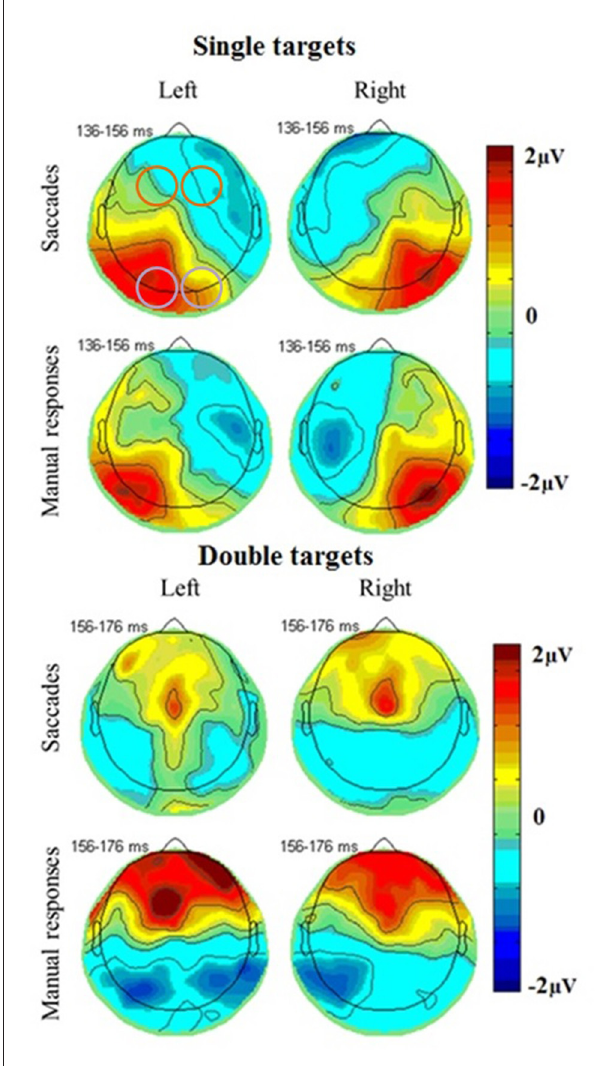
FIGURE 4 | Topographical plots of EEG responses in single (top) and double (bottom) target conditions averaged across all subjects. The electrode clusters extracted for analyses are marked in orange (frontal cluster around FC3 [EGI 12, 13, 19, 24, 20, 28, 29] and FC4 [EGI 4, 5, 111, 112, 117, 118, 124]) and purple (occipital cluster O1 [EGI electrodes 65, 66, 70, 71, 69, 74] and O2 [EGI electrodes 90, 84, 76, 83, 82, 89]) in the first plot. A posterior response to single targets on the left (left plots) and right (right plots) side of the screen is more pronounced in the ipsilateral hemisphere for both saccades (top) and manual responses (bottom) and coincides with a fronto-central negativity. Double target trials in which subjects subsequently responded to the right (right plots) or left (left plots) target show a late frontal positivity coinciding with a posterior negativity for both saccades (top) and manual responses (bottom) that is not lateralized with respect to the selected target but slightly more pronounced in the left side of the brain. observed for the posterior positivity and confirming that there was a difference in neural responses between covert and overt attention shifts. In addition, there was an interaction of target number and response type, F ( 1,330 ) = 8.30, p = 0.004, with greater latency differences between response types for double than for single